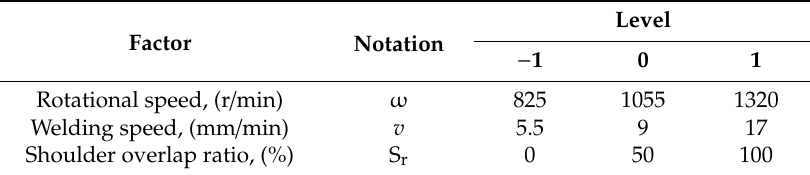
Table 3. Feasible operating limit of FSW